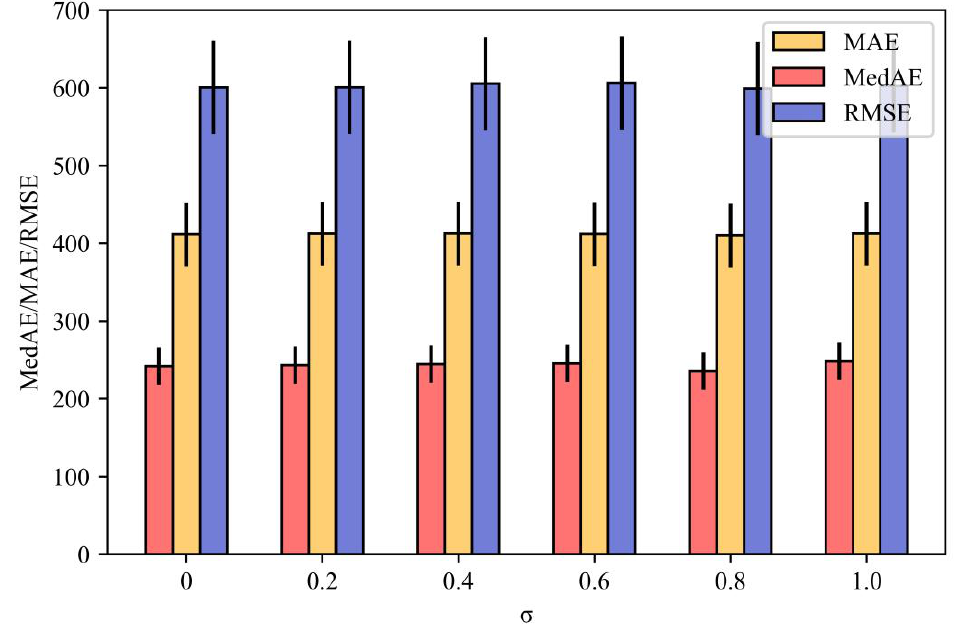
Figure 14. Perturbation analysis (P2